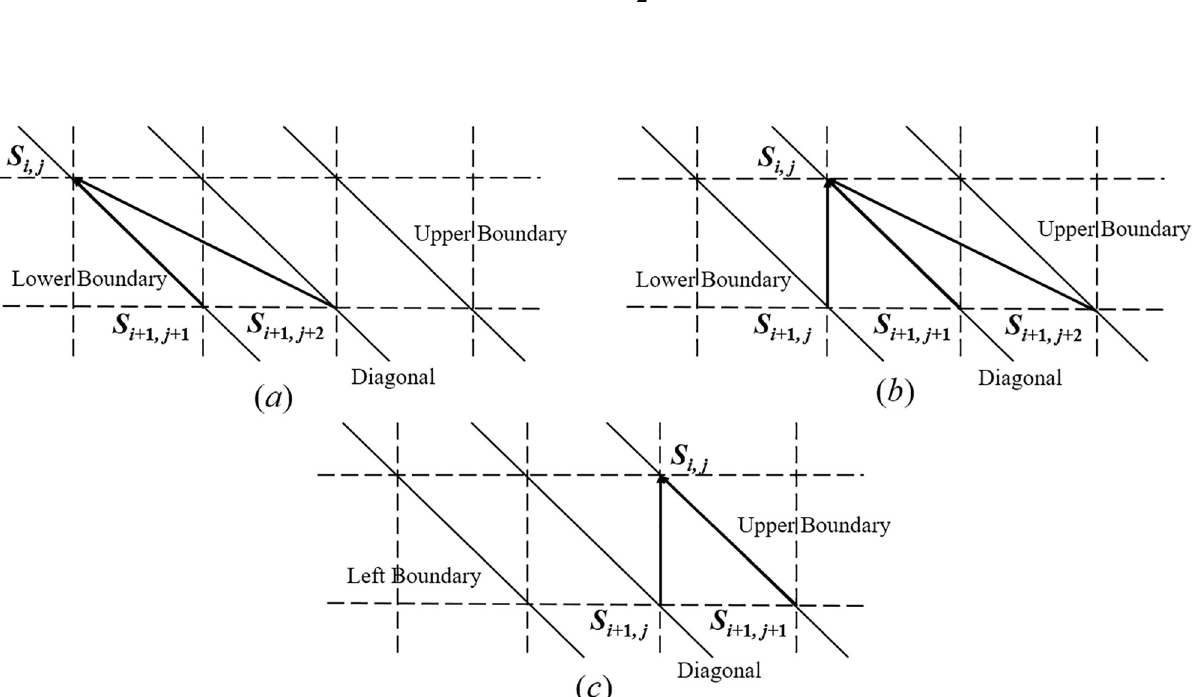
is transmitted on condition that S i +1